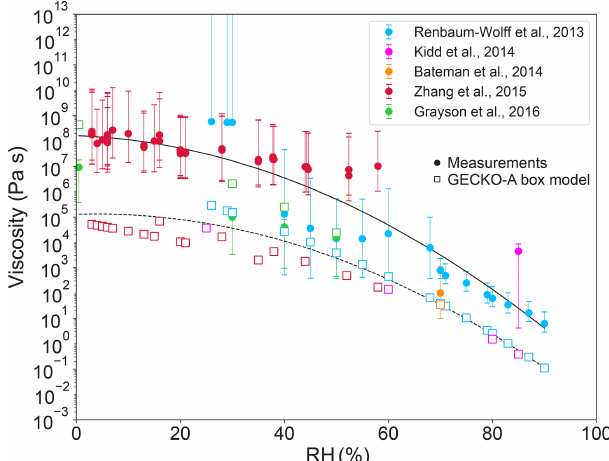
Figure 1. Viscosity of isoprene SOA as a function of RH. Circle markers with error bars represent measurements and associated un- certainties by Song et al. (2015), and square markers represent sim- ulations with the GECKO-A box model with different κ values.